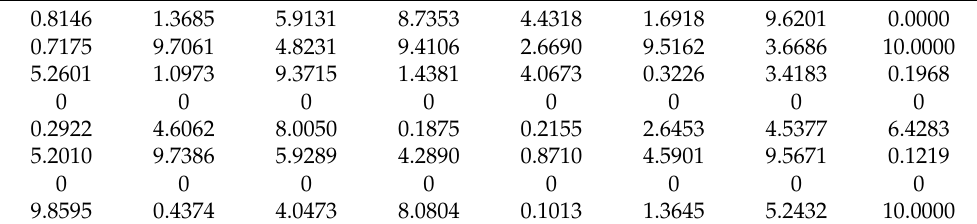
Table 3. Optimized weights for Type 1 failure for the SA method.